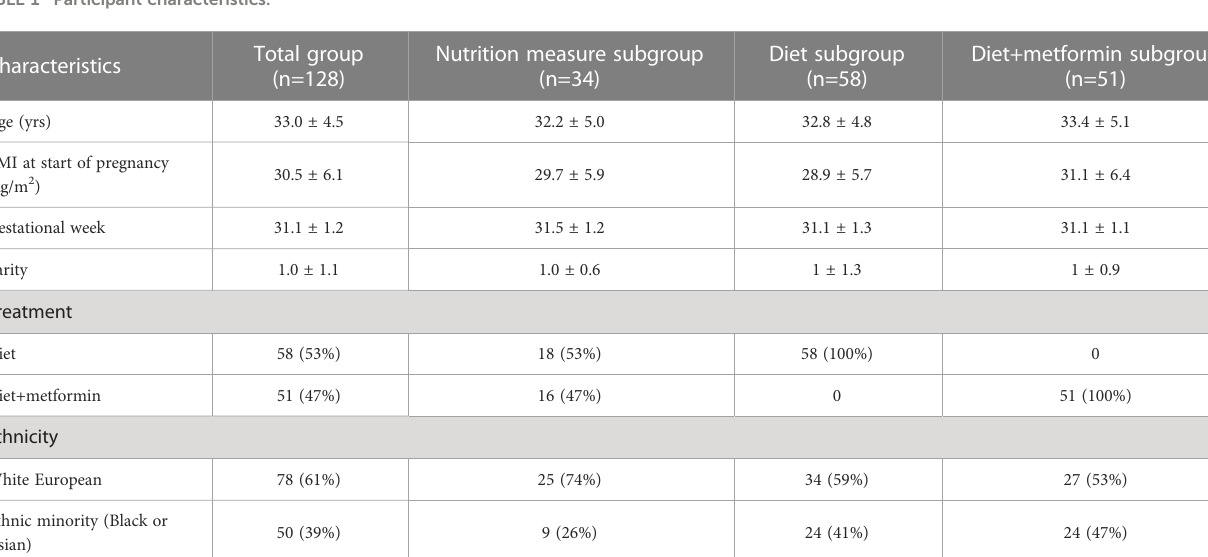
TABLE 1 Participant